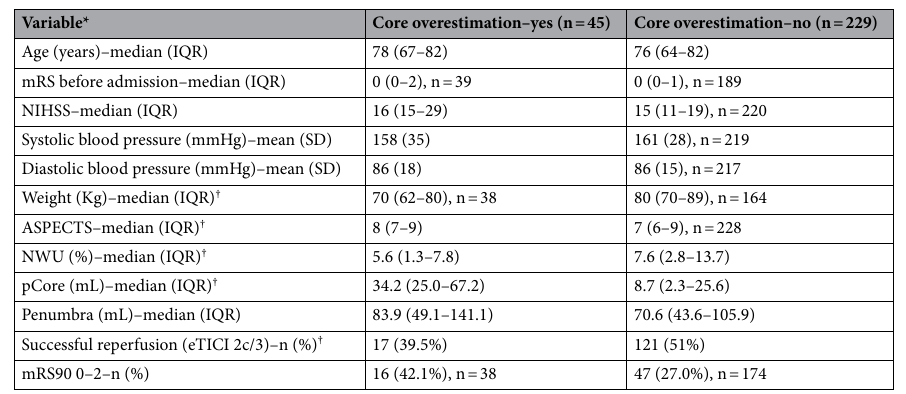
Table 1. Baseline, imaging, and procedural characteristics of the study sample (n = 284), stratified by core overestimation. IQR interquartile range; mRS modified Rankin scale; NIHSS National Institutes of Health Stroke Scale; ASPECTS Alberta Stroke Program Early CT Score; NWU net water uptake; pCore CTP-defined core volume, eTICI expanded Thrombolysis in Cerebral Infarction scale. * n is provided only in case of missing values. † Wilcoxon rank sum test p <